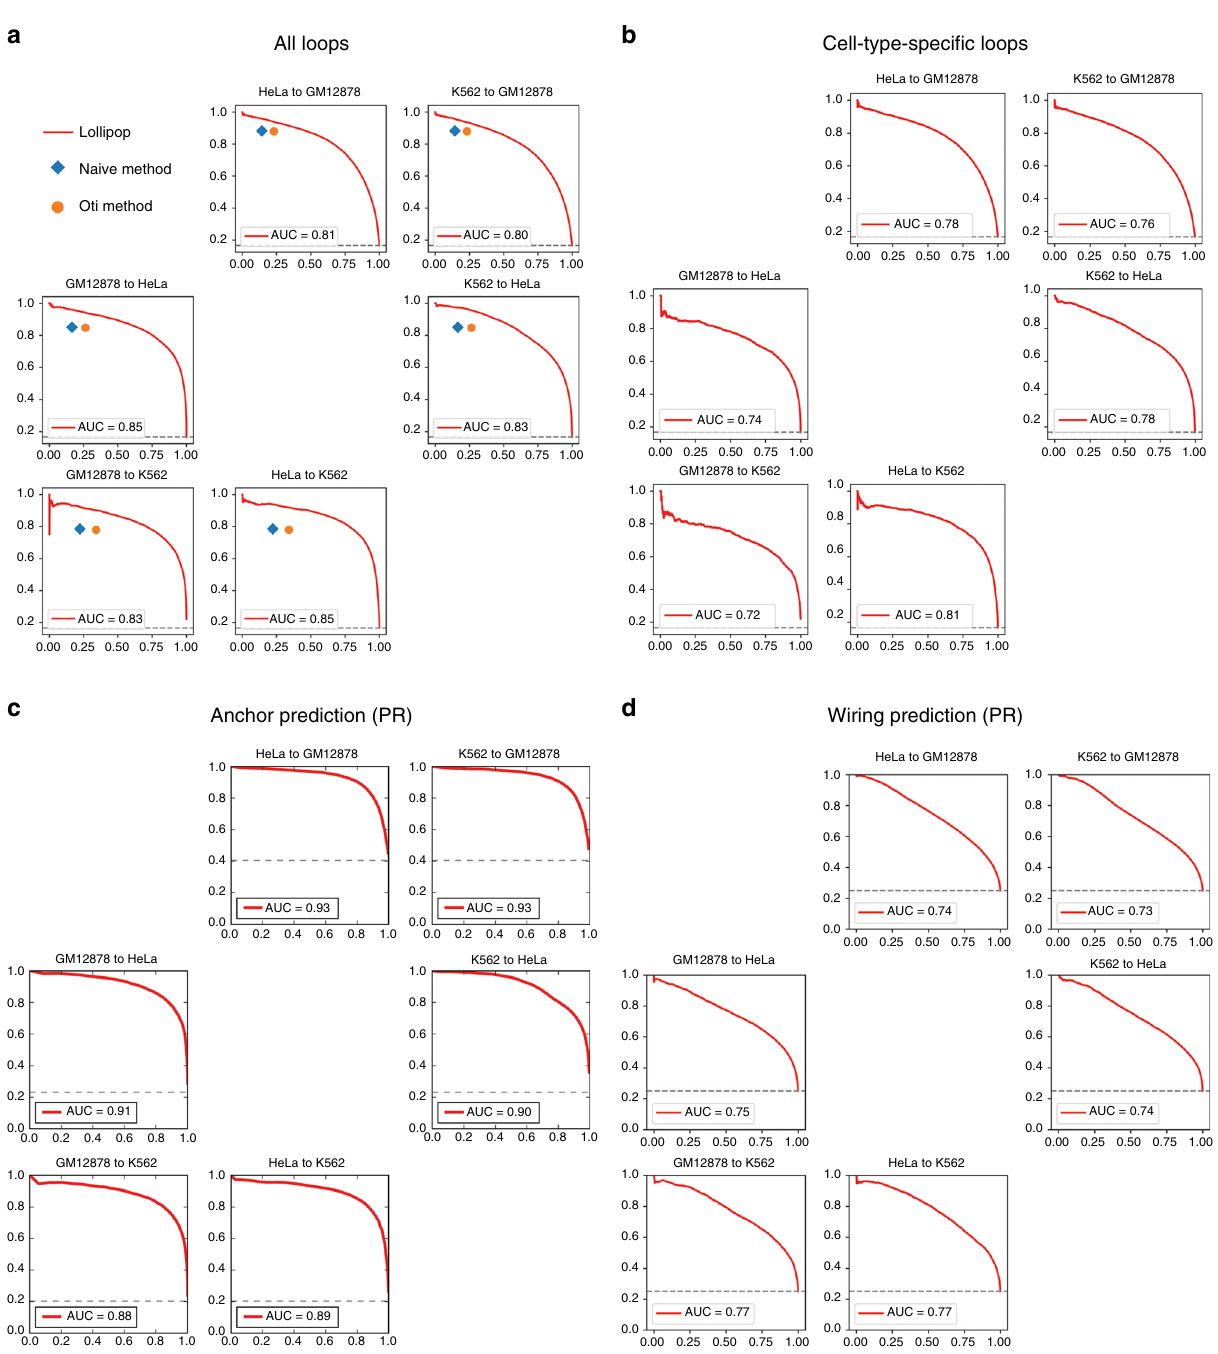
Fig. 5 Performance evaluation of Lollipop across cell types. a Across-cell-type performance evaluation using PR curves. In each subplot, “ cell A to cell B ” applies the model trained from cell-type A to the data of cell-type B. For comparison, the performance of the naïve and Oti methods in each cell type were represented by diamonds and circles, respectively. b Across-cell-type performance evaluation on cell-type-speci fi c loops using PR curves. c Performance evaluation of anchor prediction using PR curve. d Performance evaluation of wiring prediction using PR curve. The dash lines in a – d represent baseline